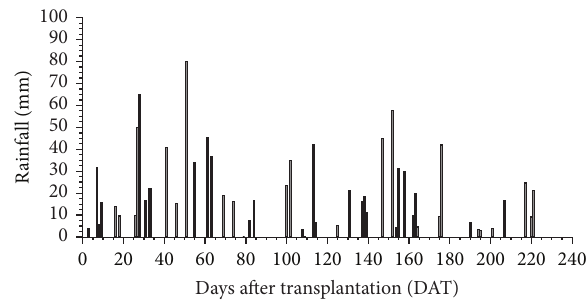
Figure 3: Rainfall during tobacco crop